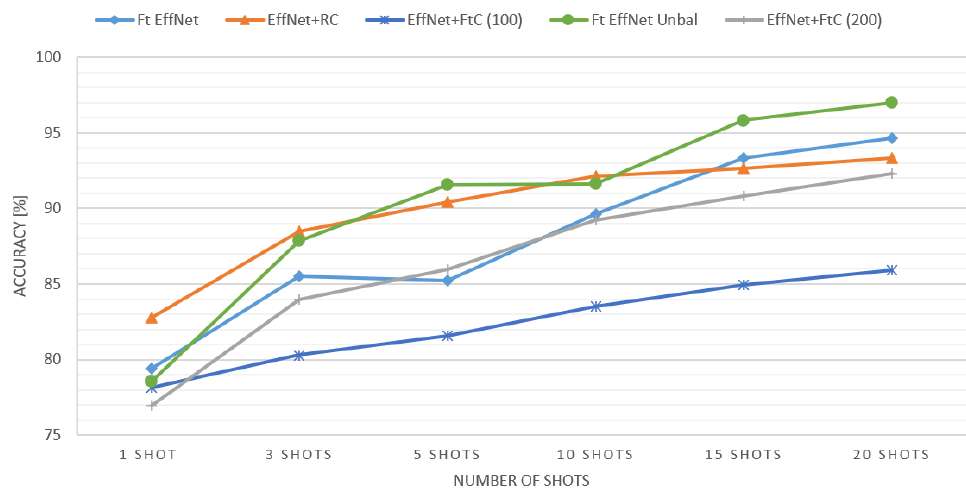
Figure 6. The accuracy of the different classification models for all classes (base and new). Ft EffNet: fine-tuned EfficienNet-B7; EffNet+RC: fixed EfficienNet-B7 backbone plus randomized classifier; EffNet+FtC: fixed EfficienNet-B7 backbone plus fine-tuned classifier; Ft EffNet Unbal: fine-tuned EfficienNet-B7 with unbalanced